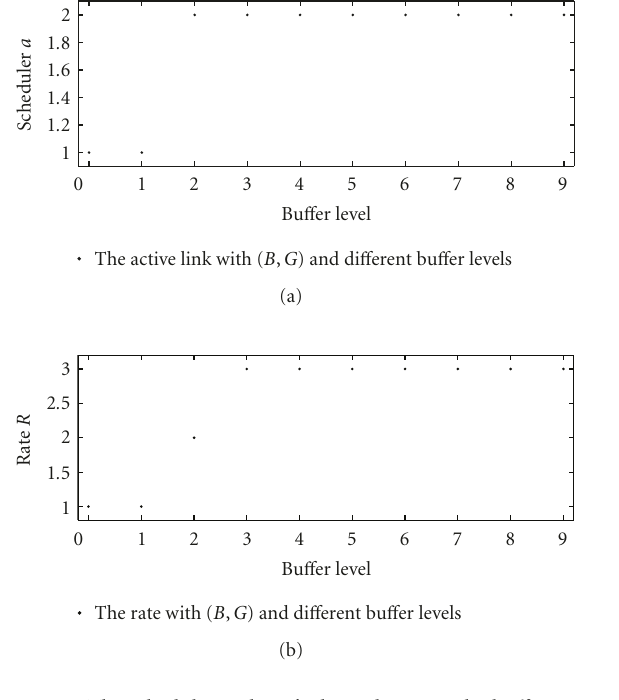
Figure 9: The scheduler and rate’s dependence on the bu ff er state with limited load. The channel condition is ( B , G ).